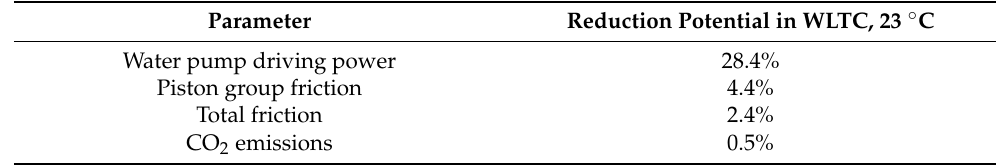
Table 1. Technology (electric water pump and thermal management module) and control strategy optimization results for the WLTC at 23 ◦ C ambient temperature compared to the baseline with mechanical pump and wax